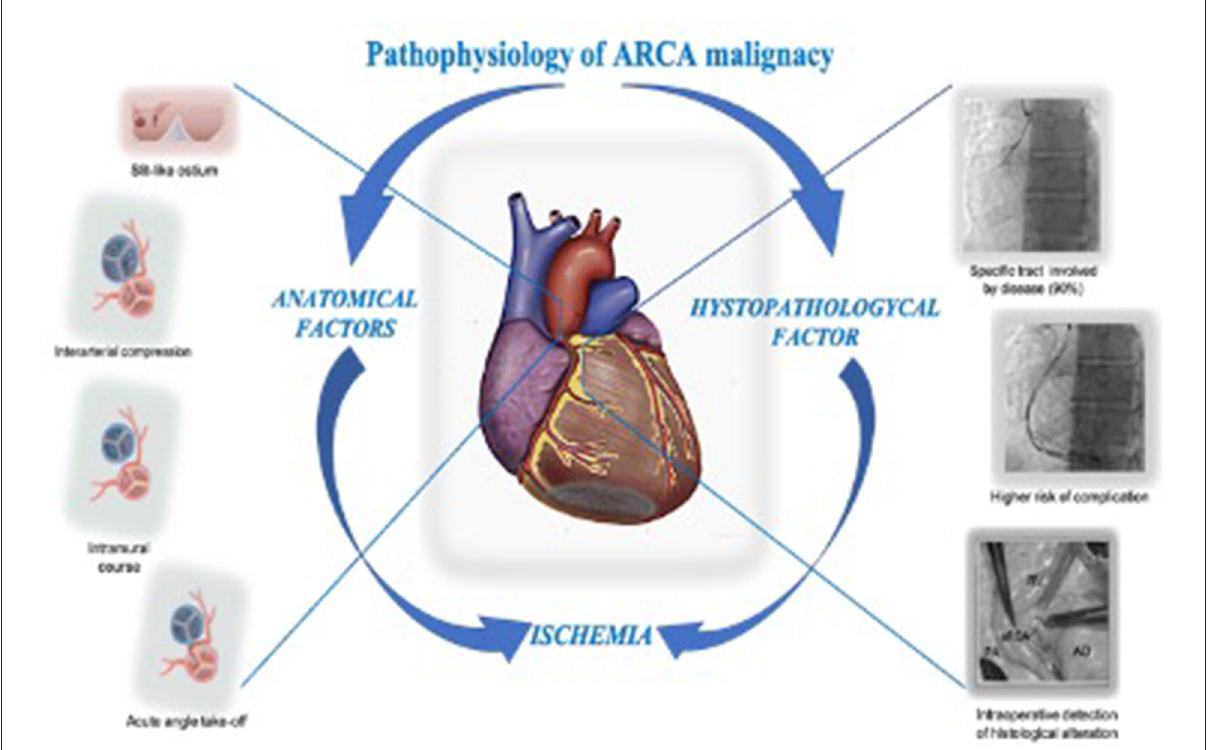
FIGURE6 ARCA presumed ischemia pathophysiology: The downstream event in the pathophysiology of ARCA malignancy in the contest of SCD is presumed to be ischemic. The anatomical feature like the interarterial passage causing compression in a scissor-like mechanism, the slit-like ostium acting as an ostial stenosis, the acute take-off angle causing kinking, and the intramural course causing compression, are historically considered involved in the pathogenesis of ischemia. Unfortunately, in clinical practice none of these have been shown to be useful in the prognostic assessment of SD. The higher incidence of procedural complications in the context of ARCA CTO treatment, the presence of a specific tract of the artery involved by the disease (90% of the case reported in literature), and the intraoperative detection of histological alteration of the anomalous artery wall in a patient who suffered from a SCA call us to reconsider the histopathological alteration in the pathogenesis of ischemia and ARCA malignancy. ARCA, anomalous right anomalous coronary originating from the left side; CTO, chronic total occlusion; SCD, sudden cardiac